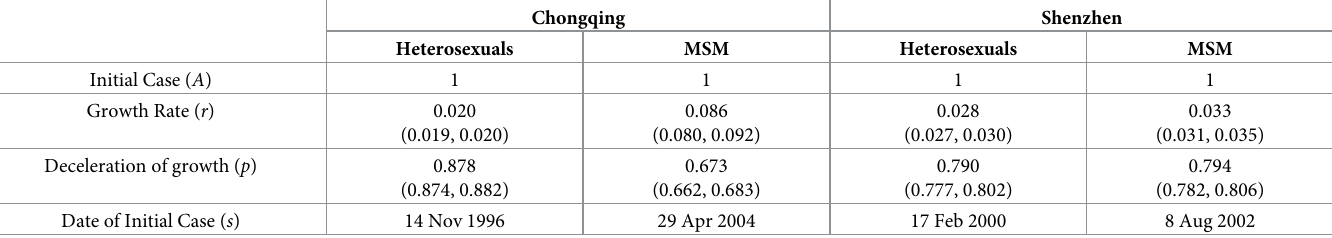
Table 1. Summary of parameter estimates with 95% CIs in parentheses of the sub-exponential models for epidemic growth for heterosexuals and MSM in Chong- qing and